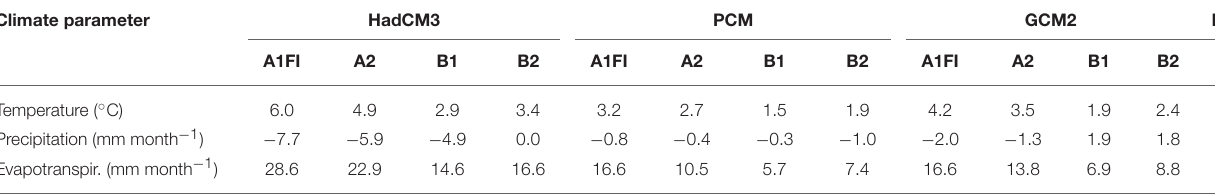
TABLE 2 | Variation in climate parameters for Italy between 2001 and 2100 for 12 different climate scenarios. Climate parameter HadCM3 PCM GCM2